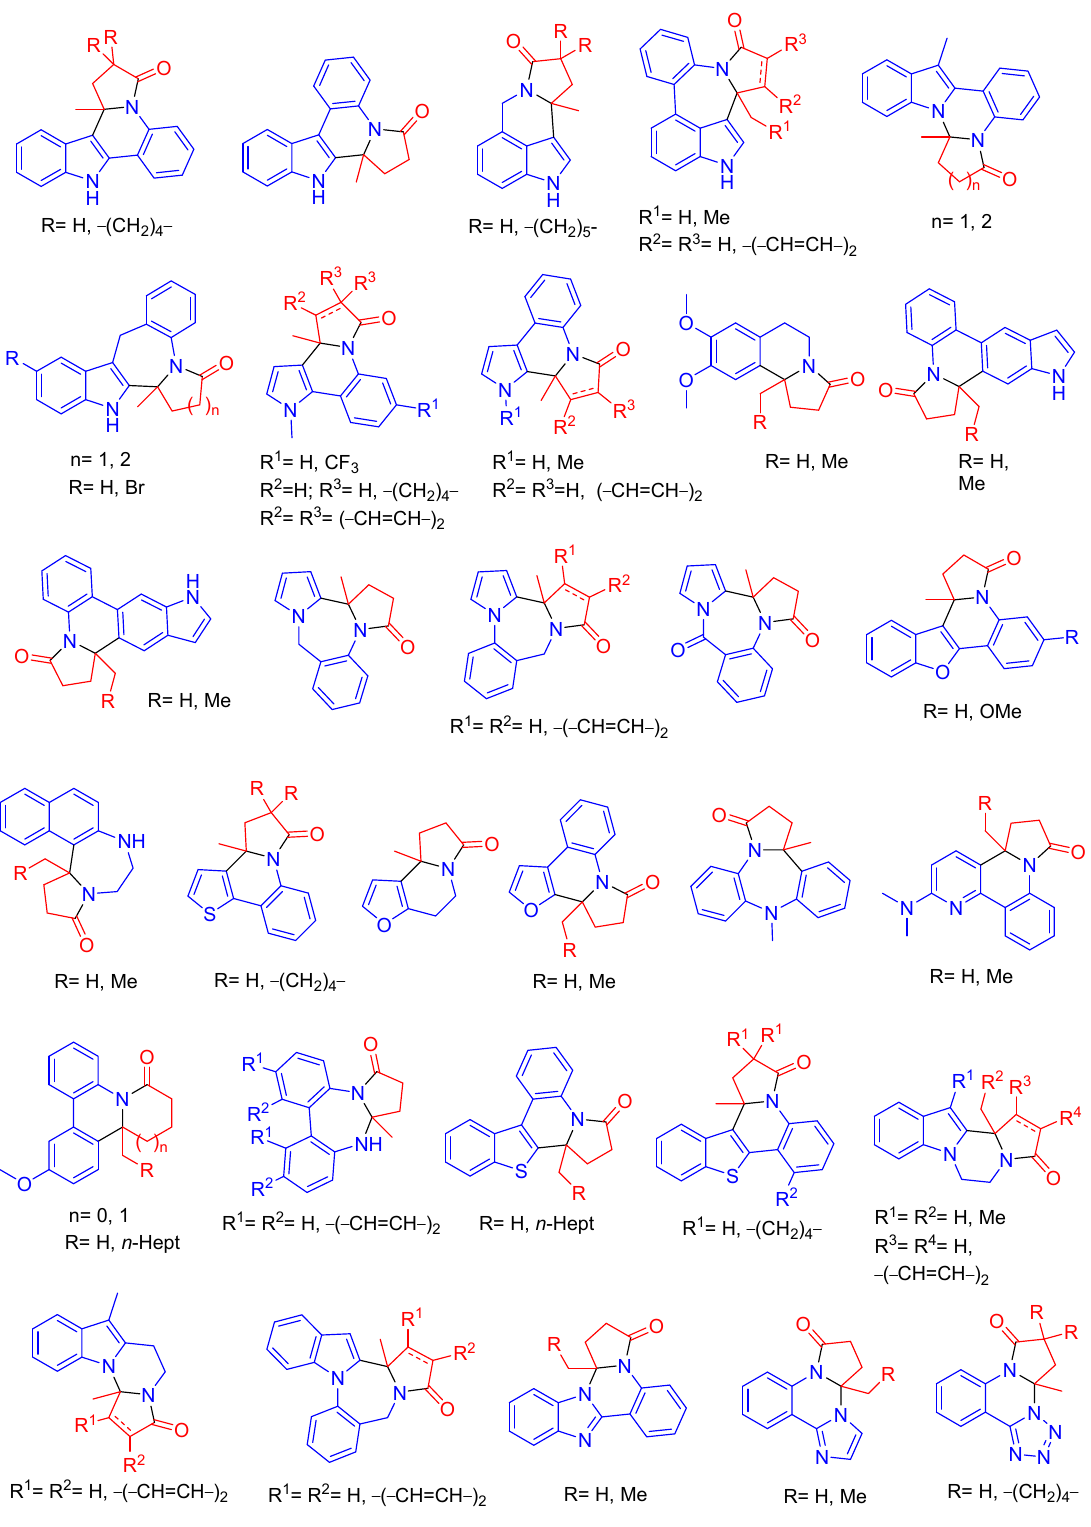
Figure 3. Library of compounds prepared by a relay catalytic branching cascade from alkynoic acids and dinucleophiles. Note: The moieties derived from alkynoic acids and dinucleophiles are depicted respectively in red and blue in the final products.